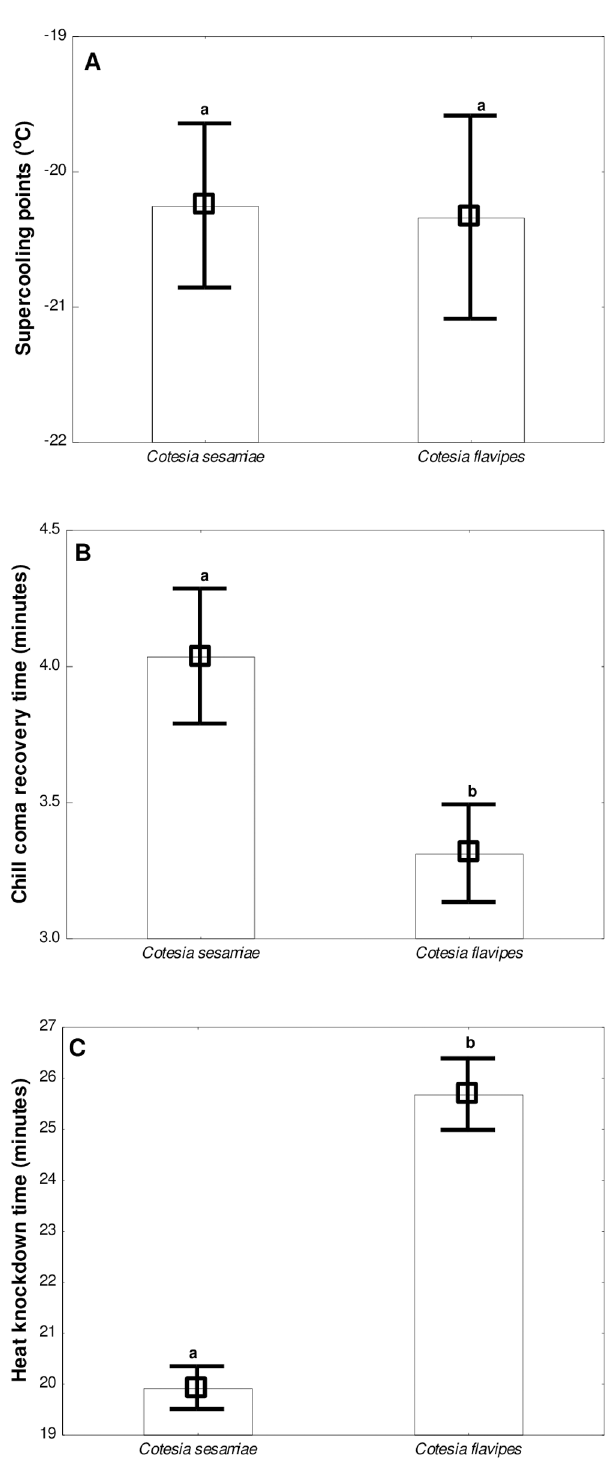
Fig 3. The effect of species ( Cotesiasesamiae and Cotesiaflavipes )on (A) supercooling points (N = 16 per group), (B) chill coma recovery time (at 0˚C chill coma temperature) (N = 30 per group) and (C) heat knockdown time (at 45˚C knockdown temperature) (N = 30 per group). Error bars represent 95% confidence limits. Means with the same letter are not significantly different from each other according to Tukey-Kramer’s post-hoc tests.